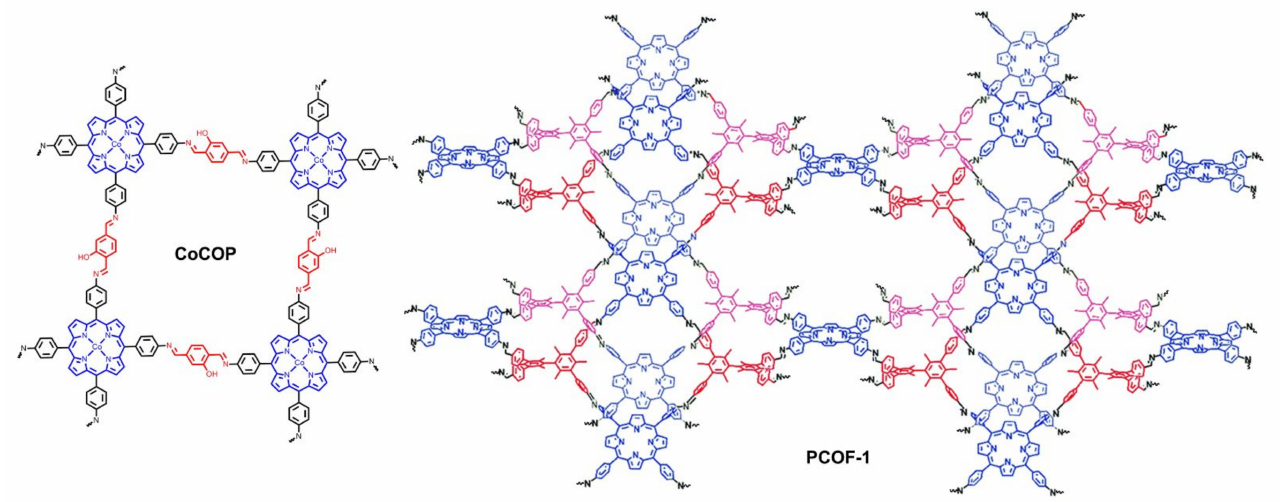
Figure 12. Porphyrin-based Schiff-base type covalent organic frameworks for heterogeneously electrochemical OER. Reproduced from ref. [81]. Reprinted with permission from ref. [82].